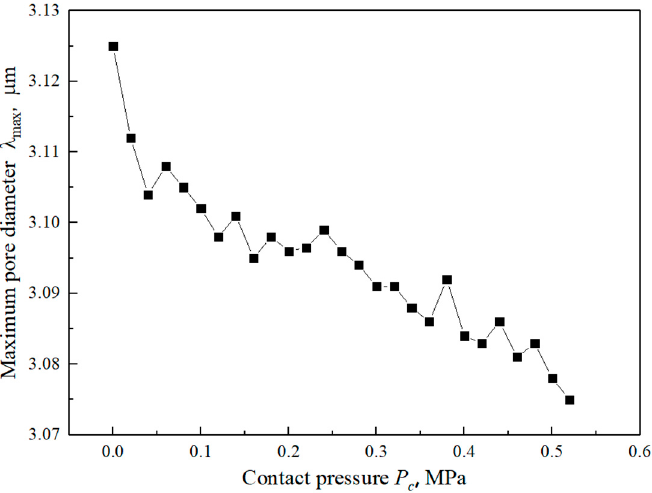
Figure 14. Distribution of the contact pressure against the maximum pore.